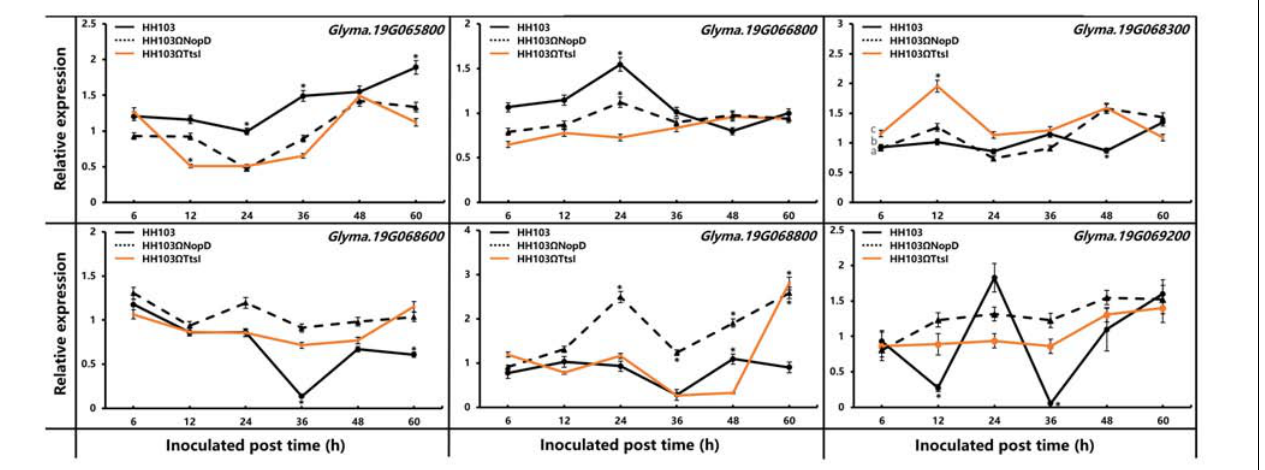
FIGURE 5 | Relative expression of Glyma.19g065800, Glyma.19g066800, Glyma.19g068300, Glyma.19g068600, Glyma.19g068800 , and Glyma.19g069200 was measured by qRT-PCR in RNA extracted from roots of soybean Suinong14 plants inoculated with S. fredii HH103 wild-type or mutants HH103 (cid:127) NopD and HH103 (cid:127) TtsI . Uninoculated Suinong14 plants were used as the control. The 2 − (cid:49)(cid:49) Ct method was used to calculate the relative expression levels of candidate genes. Error bars indicate the mean ± standard error of three replications. Significant differences were determined by t -tests, and “*” indicated the significant differences ( p ≤ 0.05) at the time point.